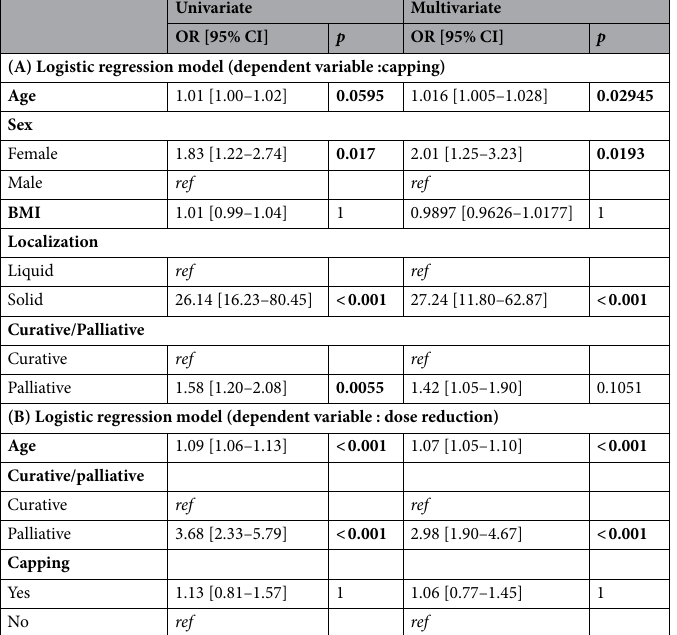
Table 7. Univariate and multivariate logistic regression (A) capping as dependent variable, (B) dose reduction as dependent